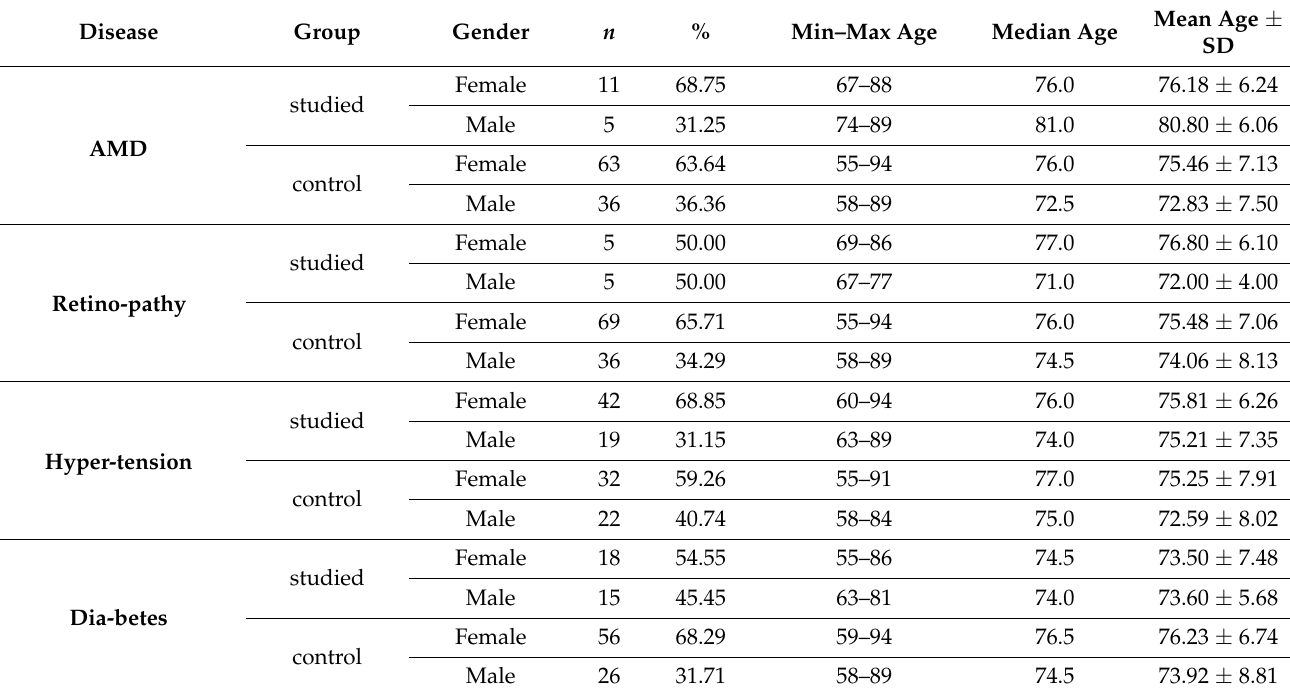
Table 3. Demographic characteristics of the patient groups enrolled in the